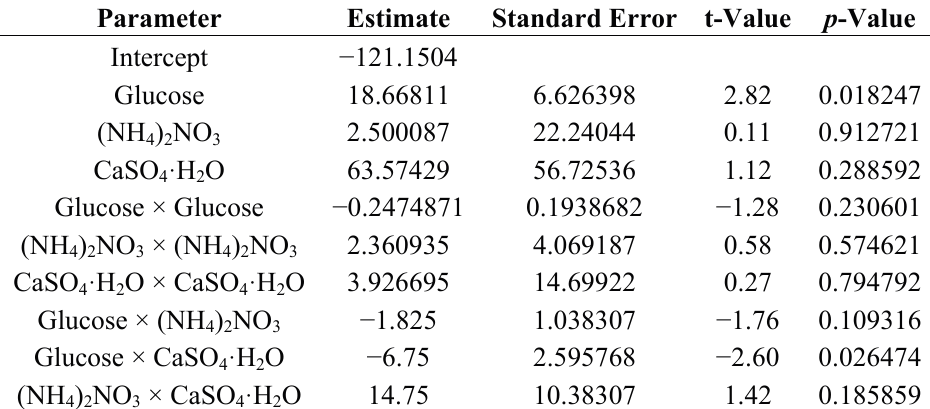
Table 6. Second order polynomial model following regression analysis of flocculation activity optimization for Brachybacterium sp. and Streptomyces sp. consortium.